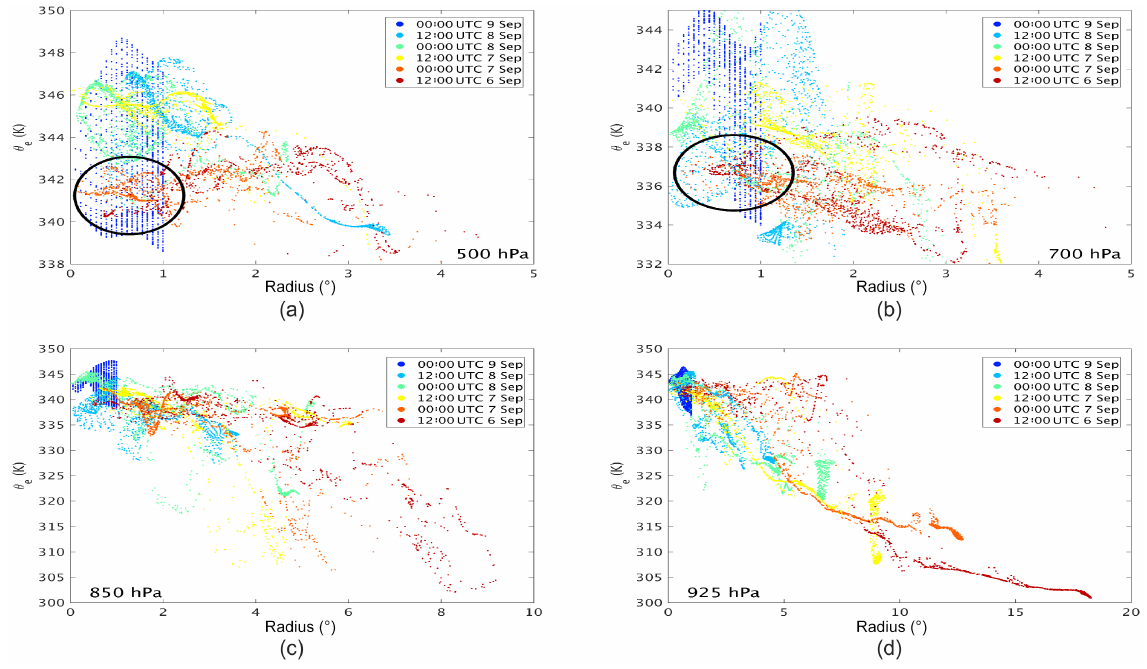
Figure 9. The values of θ e versus radius from circulation center are plotted for sets of isobaric trajectories from the ECMWF data released within the inner core boundary at 00:00UTC on 9 September and integrated backward to 12:00UTC on 6 September at 500, 700, 850, and 925hPa (a–d) , respectively. The different colors indicate the time at which the properties of the trajectories were analyzed. Sets of trajectories that remain in the core during the entire integration are located inside the black ellipse (a, b)